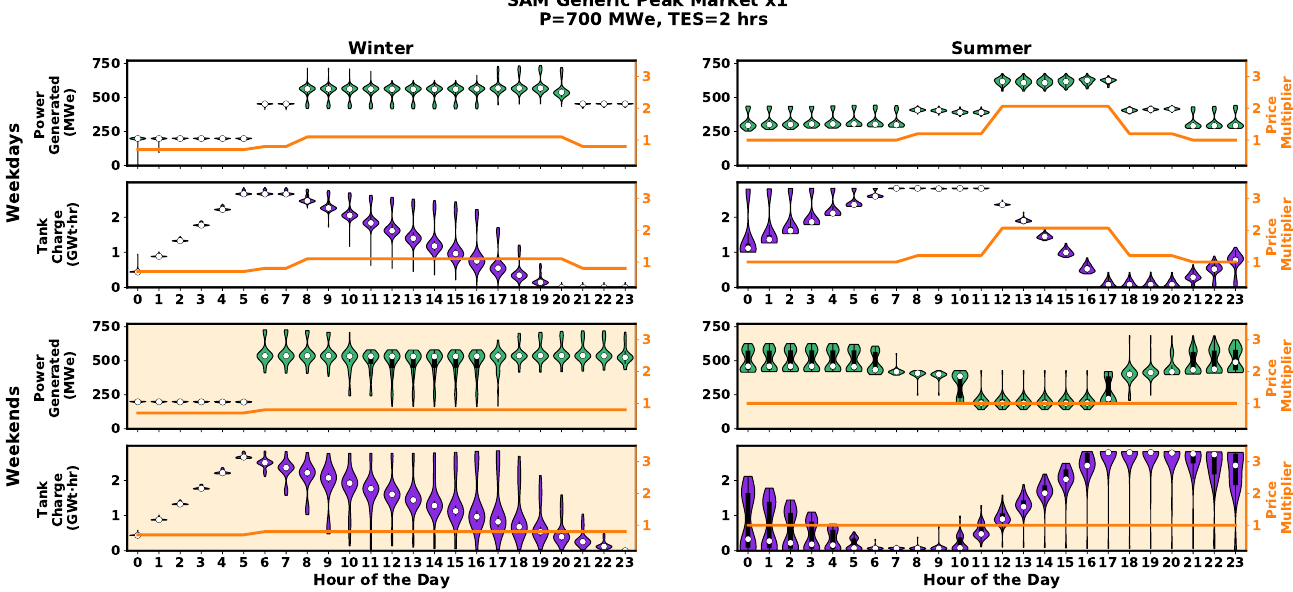
Figure 4. Hourly violin plot distributions for a year of simulated electric power and stored energy levels. Computed for a 700 MW e turbine with 2 h of TES under SAM generic peak market prices. Median value for each hour is shown as a white circle and the black vertical rectangle demarcates 25th and 75th percentiles. Distributions are split between winter and summer price schedules as well as weekday and weekend prices; price multipliers are shown on the right axis of each